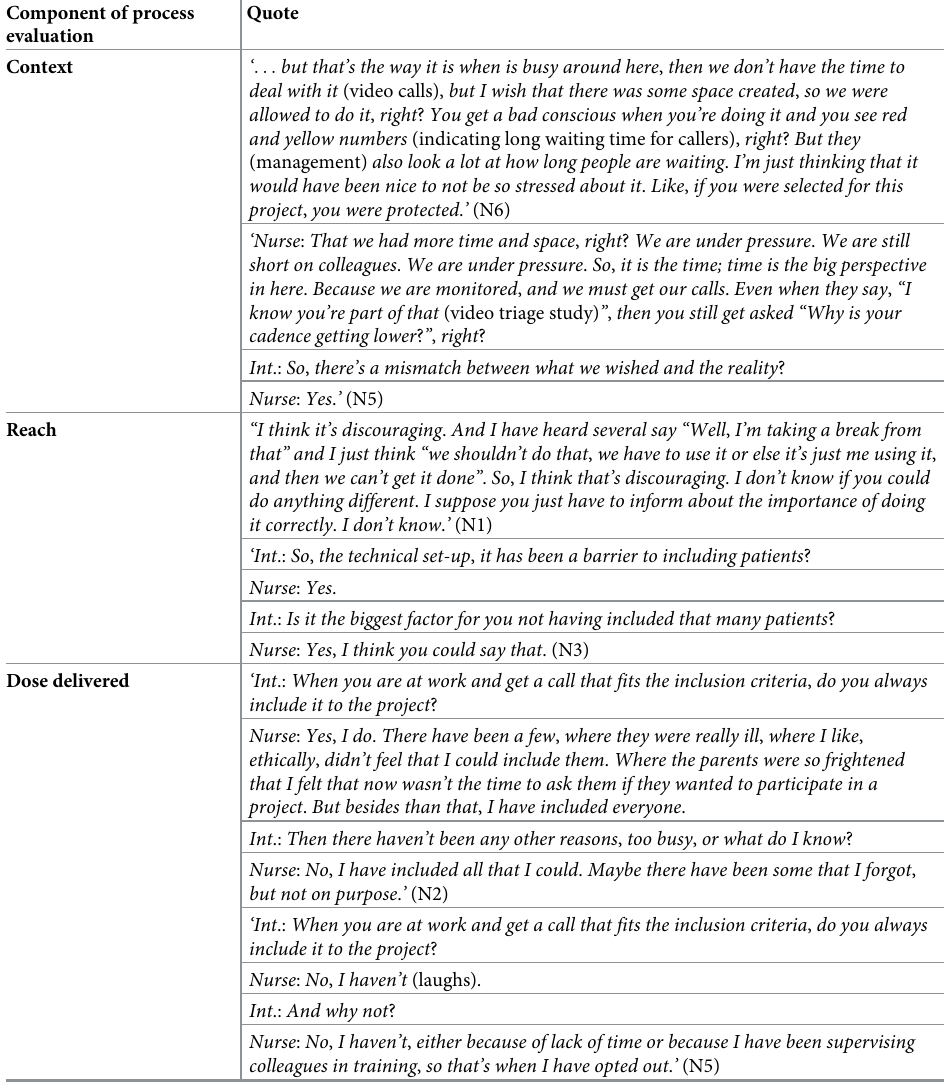
Table 5. Call-handlers’ evaluation of video triage studies. Deductive findings according to Steckler and Linnan’s process evaluation model